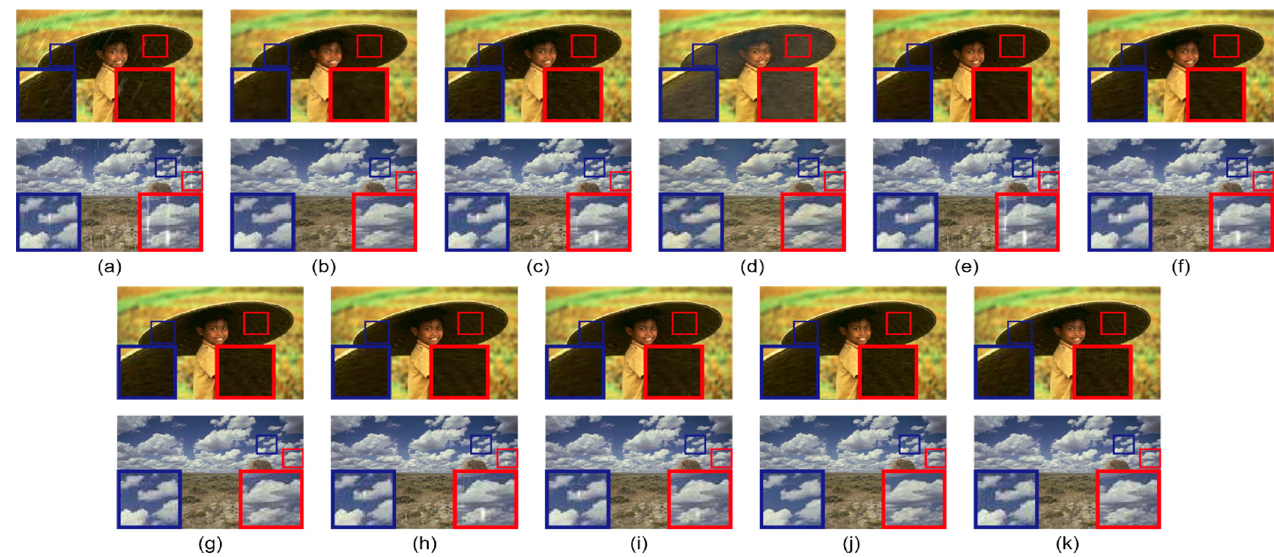
Figure 7. Deraining task performance of the proposed MARCAFNet and state-of-the-art methods when using the Rain100H dataset. ( a ) Rainy image, ( b ) RESCAN, ( c ) PReNet, ( d ) LPNet, ( e ) MSPFN,